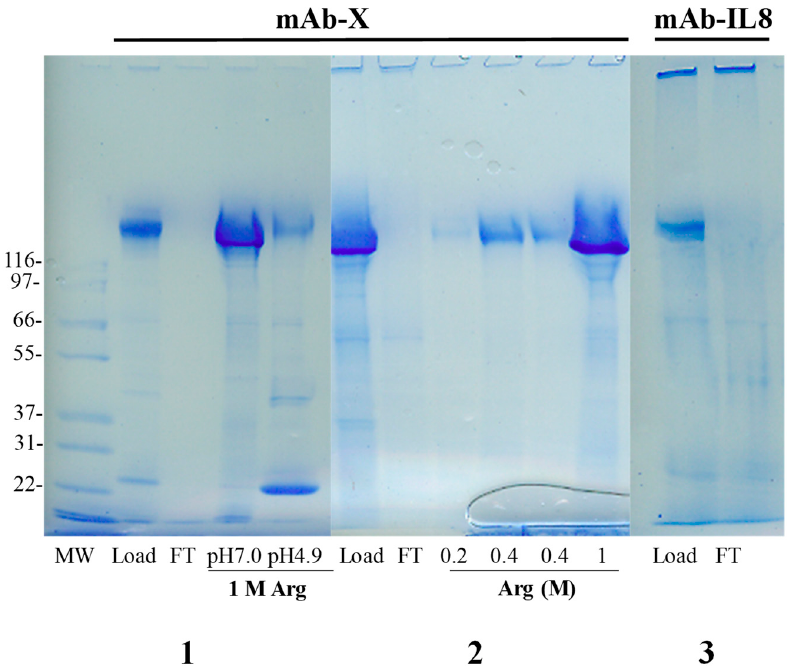
Figure 6. MEP chromatography of mAb-X and mAb-IL8. SDS-PAGE of chromatographic fractions. ( 1 ). mAb-X was loaded and eluted with 1 M arginine at pH 7.0 and pH 4.9. ( 2 ). mAb-X was loaded and eluted with arginine at 0.2, 0.4 and 1 M arginine at pH 7.0. ( 3 ). mAb-IL8 was loaded: only the load and FT are shown.